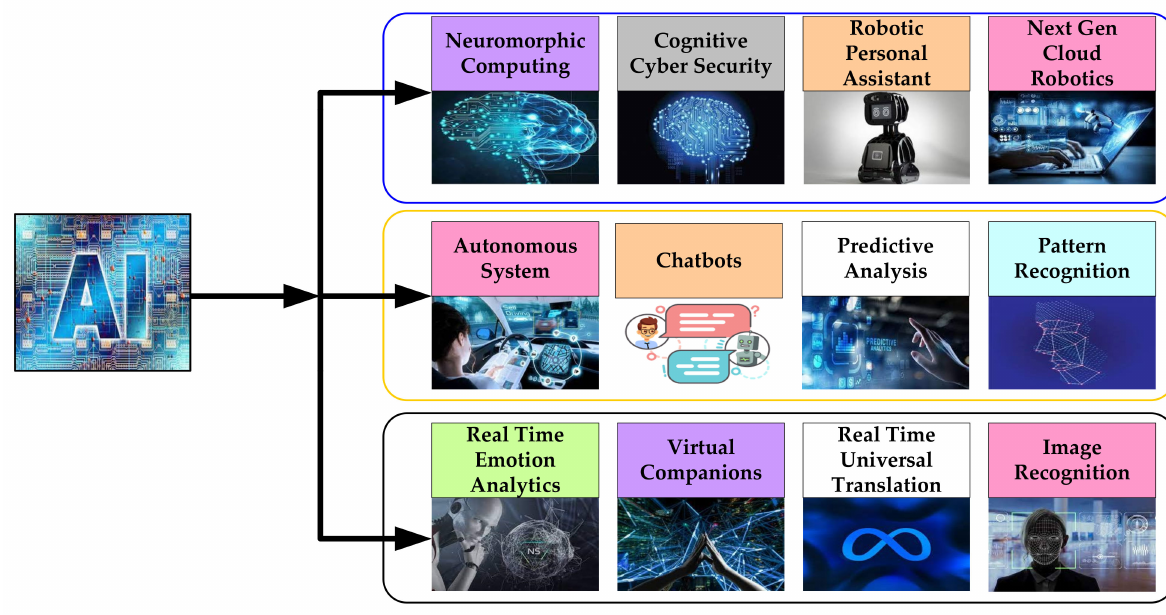
Figure 2. Framework encompassing AI-linked technologies and